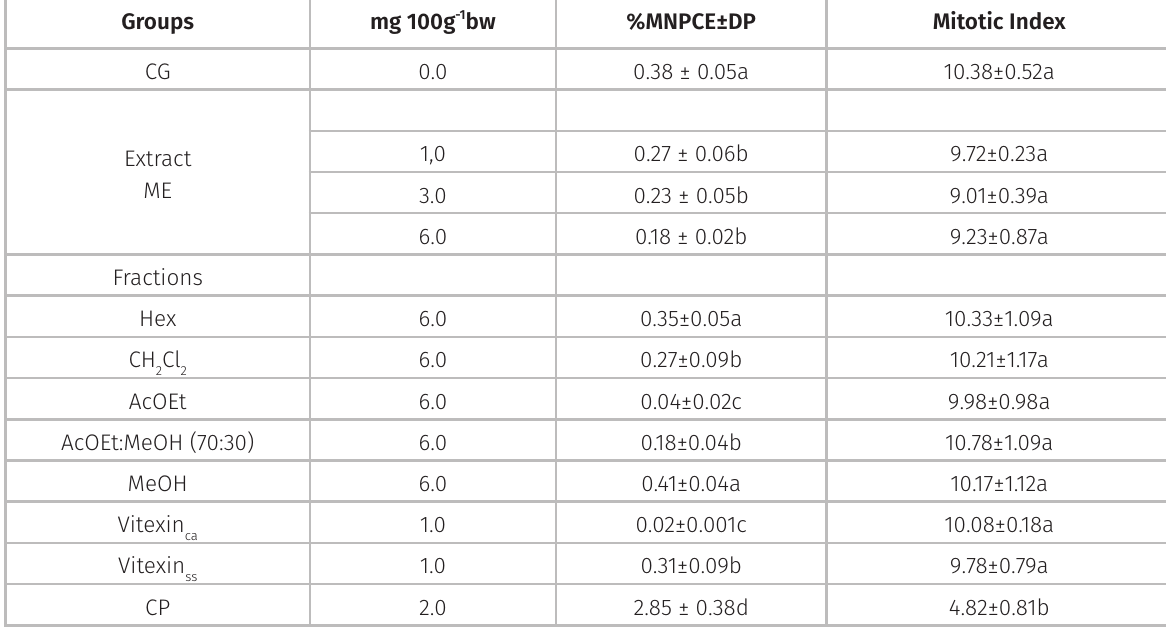
Means sharing the same letter in a column do not differ significantly by Mann-Whitney and U-test